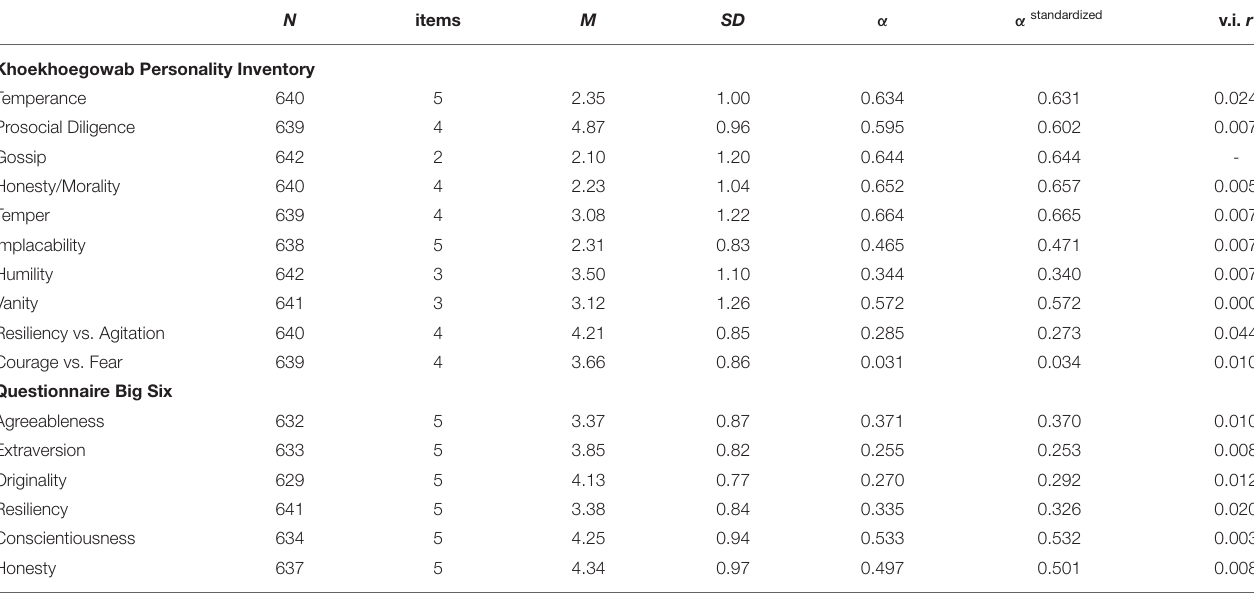
TABLE 2 | Psychometric Properties of the Khoekhoegowab Personality Inventory (KPI) and Questionnaire Big Six (QB6) in Translation to Khoekhoegowab. N items M SD α α standardized v.i.